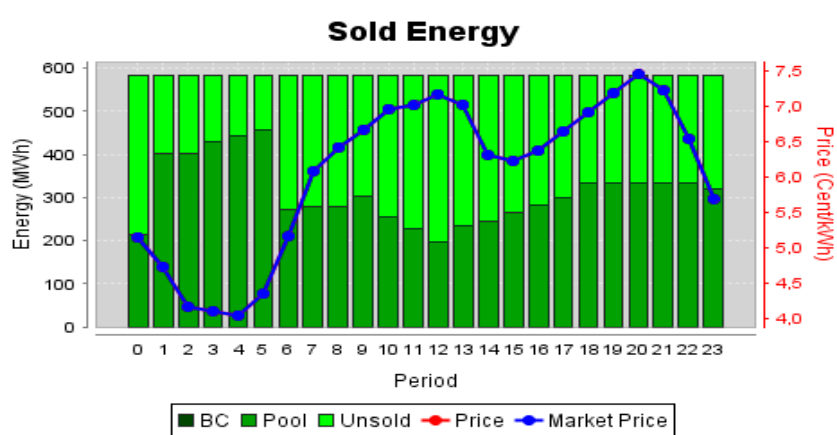
Figure 11. Energy sold on the market by Seller 2 in the first day.